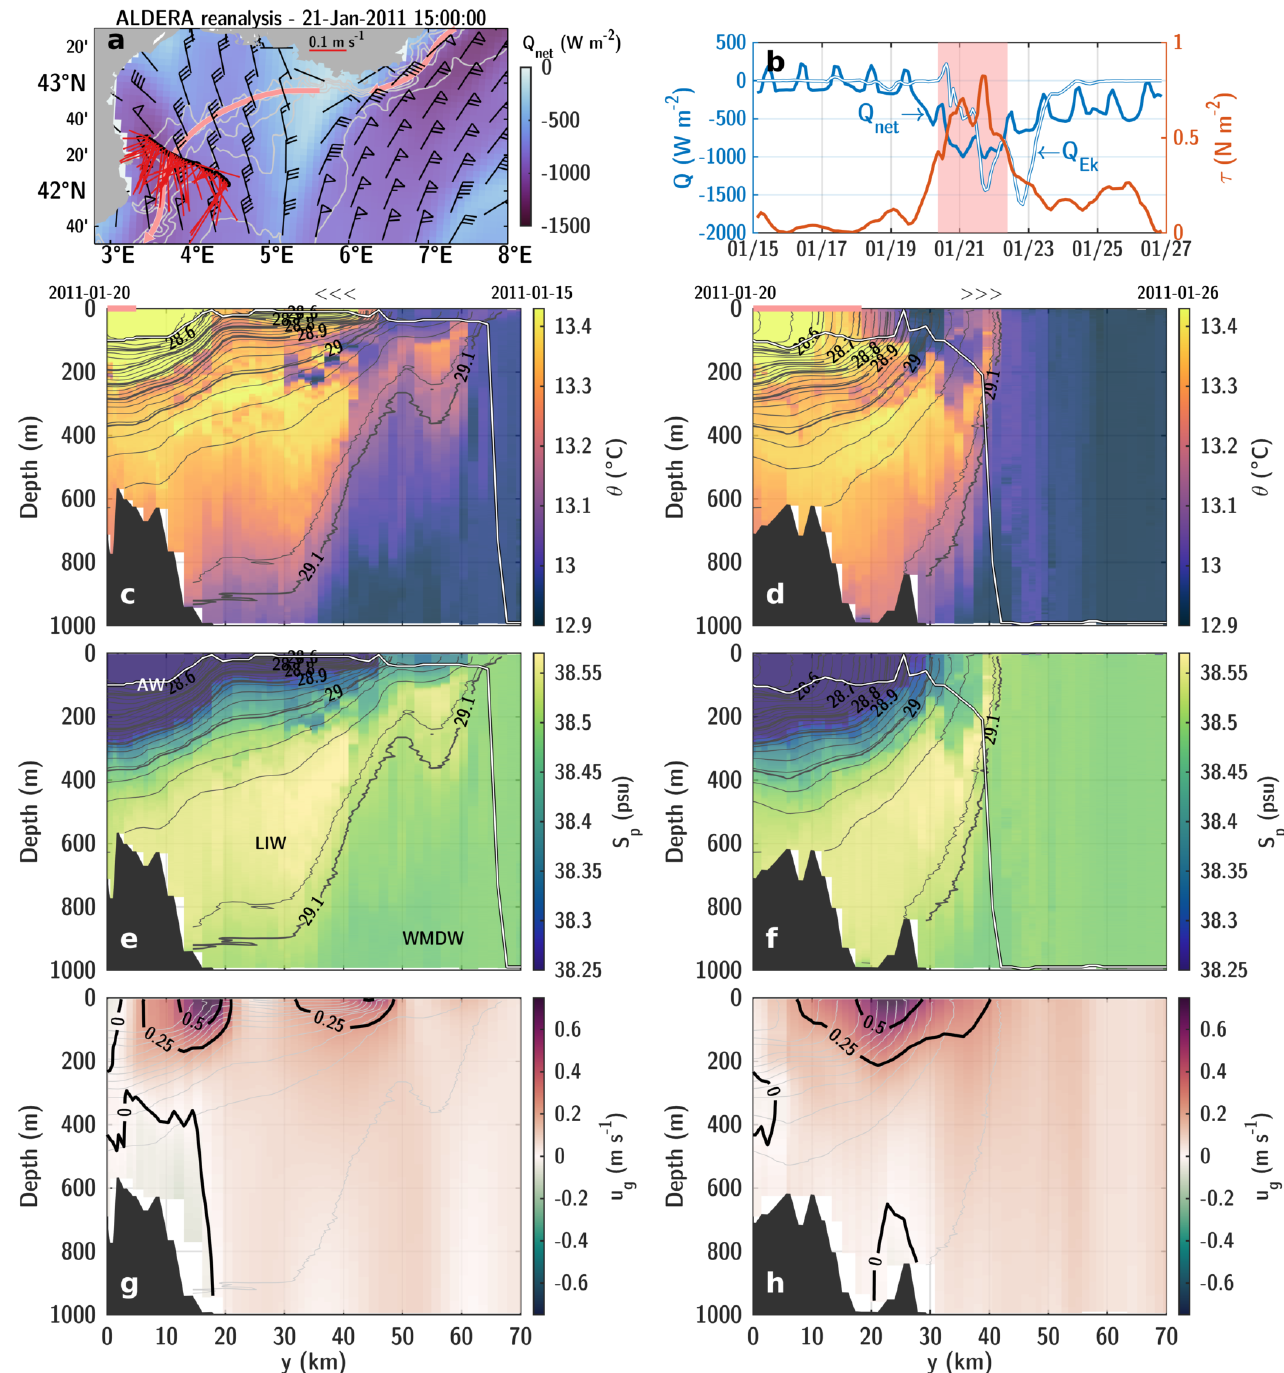
Figure 5. ( a ) Wind and air/sea heat fluxes from ALADIN reanalysis on 21 January 2011. Wind arrows show the direction and intensity in Beaufort wind force scale. Black dots in the west represent glider profiles in the section period with DAC in red. ( b ) Net surface heat flux (in blue), Ekman equivalent heat flux (in white) and wind stress (in red) interpolated along the glider sampling. The period of intense winds peaking on the 21st of January is highlighted in red, as well as in the glider sections in panel c and d. Glider section of ( c ) potential temperature and ( e ) practical salinity with MLD shown by the white line and isopycnals contours in black. The main water masses are labeled (AW: Atlantic Water, LIW: Levantine Intermediate Water, WMDW: Western Mediterranean Deep Water). ( g ) Glider-based absolute geostrophic currents with isopycnals contours in gray. ( d , f , h ) Same as ( d , e , g ) for the second glider crossing of the NC